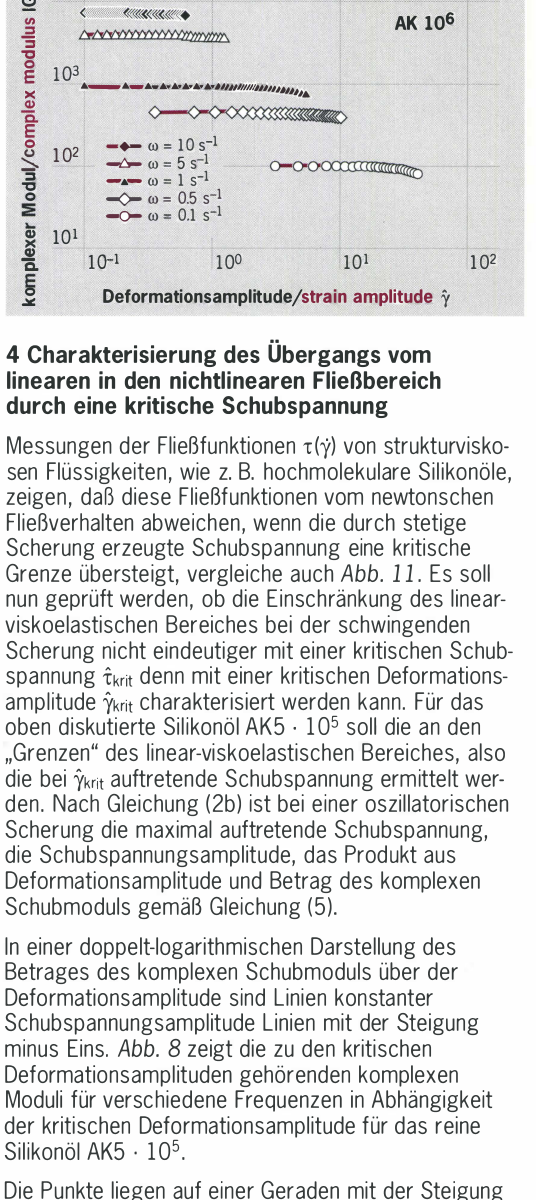
Fig. 3: Dependence of the complex shear modulus on the strain amplitude for silicone oil AKI06 at various frequencies